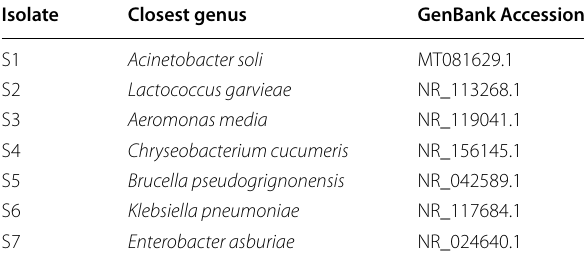
Table 1 Identification of bacteria in the OS of field-collected SSB